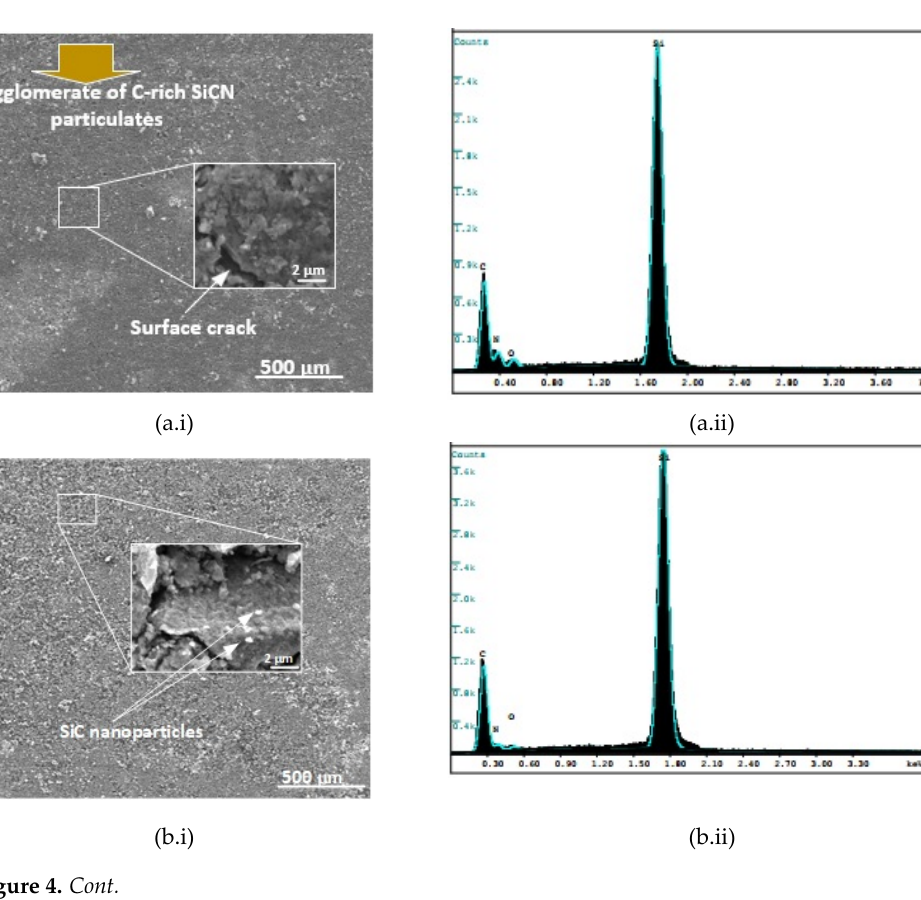
Table 2. The chemical composition of the C/SiCN nanocomposites after pyrolysis.